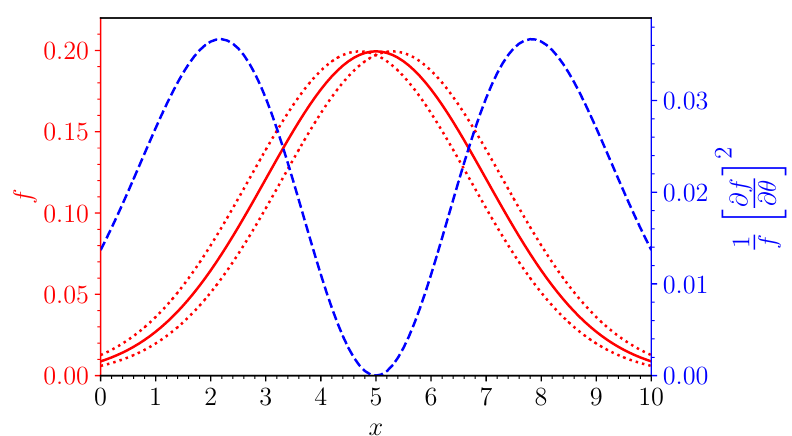
Figure 10: The three distributions of f ( x ) from Figure 1 (red solid and dotted lines, left y -axis) and the distribution of the local shape sensitivity (77) (blue dashed line, right y -axis) for our toy